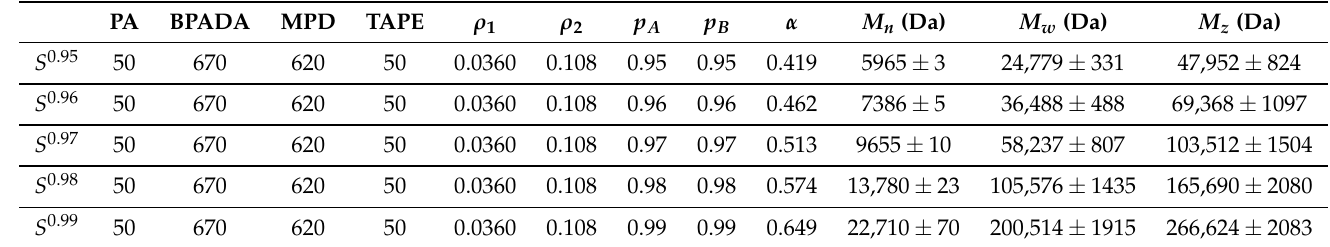
Table 4. Five partially reacted, stoichiometric systems (i.e., p A = p B < 1). The entries have the same format as in Table 2. The superscript of the system label indicates the values of p A and p B . The first two are below and the other three are beyond the gel point. The average molecular weights, M n , M w , and M z , are from the MC simulations, with 1000 runs for each system.